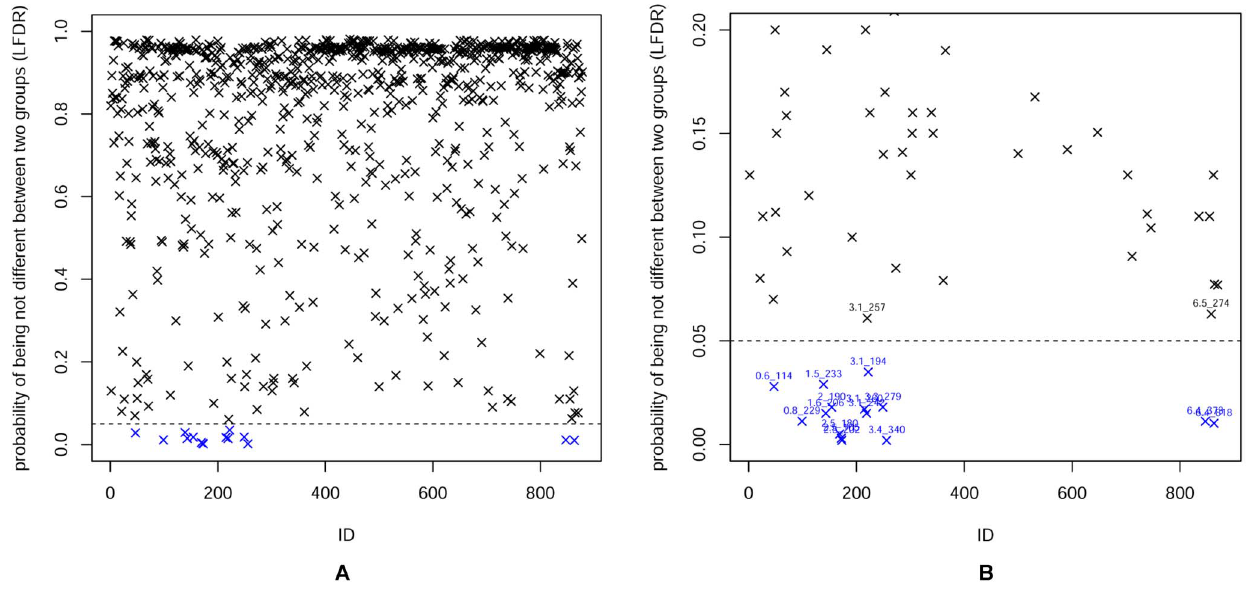
Figure 5. LFDR plot for the metabolic profiles of the GF-treated and healthy control groups. (A) LFDR from 0 to 1 (B) LFDR form 0 to 0.20. The metabolites marked by blue X with retention time-m/z pair below the dash line are identified as the potential biomarkers. 0.05 (dash line) is treated as the threshold for potential biomarkers identification.